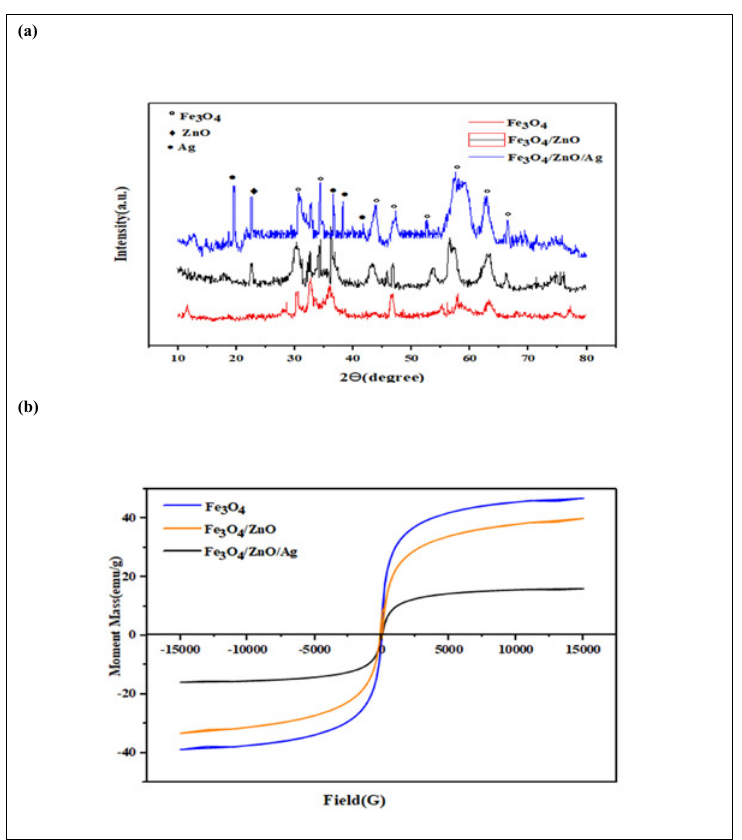
Fig.1. (a): XRD pattern of magnetic nanoparticles. (b): Magnetic properties (VSM)